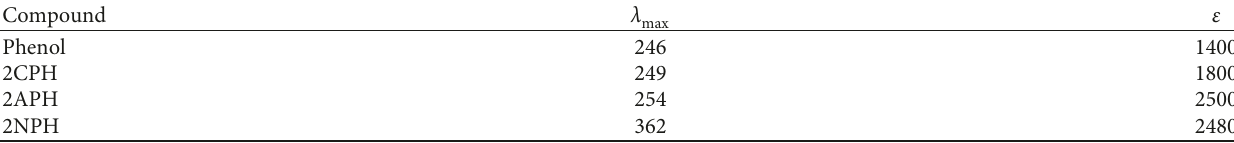
Table 2: TD-DFT calculated λ max and ε of the optimized structures.